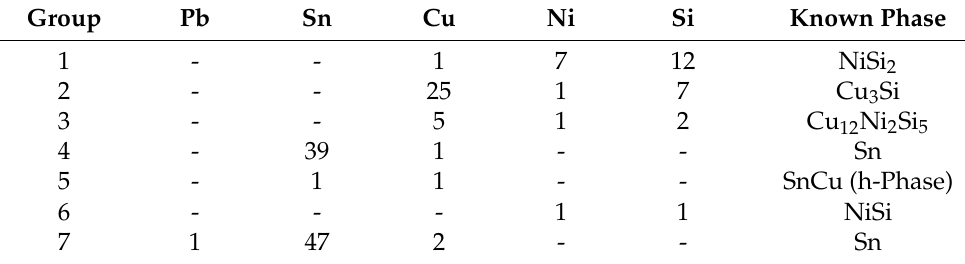
Table 6. Stoichiometric composition of the phases (according to the average values).